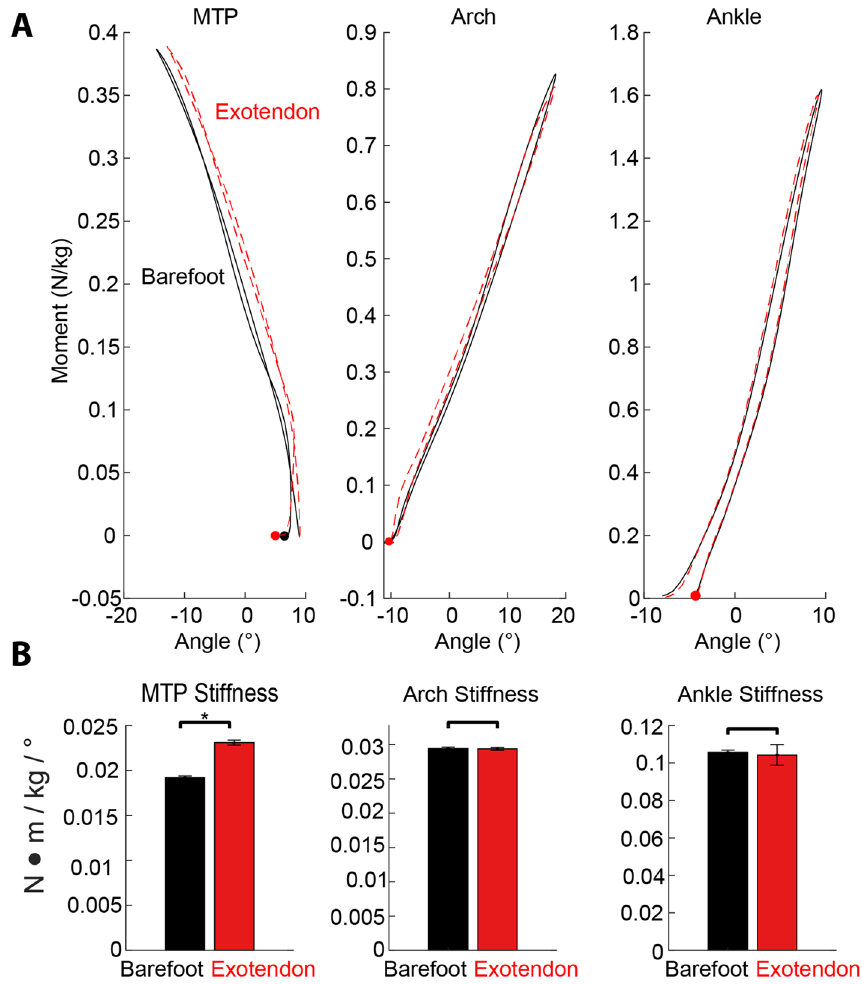
Figure 3. ( A ) Sagittal moment vs angle for the MTP, Arch, and Ankle, showing an approximately linear relationship with little hysteresis. Compare barefoot (black solid line) to exotendon (dashed red line) averaged across participants. The exotendon stiffens the MTP throughout the hopping cycle, whereas the estimated linear stiffness of the arch and ankle were largely unchanged. Dots represent first contact with the ground. ( B ) A linear fit between peak joint moment and angular deflection was used to estimate a net stiffness for the joint. The bar plot shows the mean ± S.E. for this stiffness value across the two conditions. * denotes significance, as tested by the linear mixed model which also takes statistical account for differences in stiffness that could have resulted purely from changes in muscle activation of AH for the MTP and arch, or from SOL for the